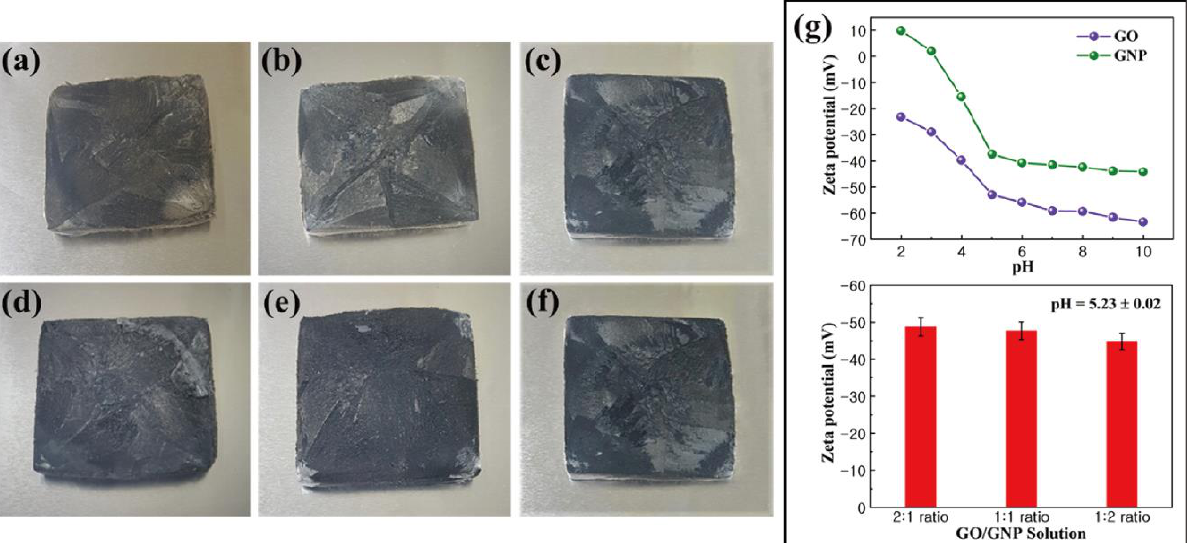
Figure 1. Schematics of the fabrication process for phase change material (PCM) composites by using the infiltration method. The thermoelectric energy harvesting system could generate induced current and turn on the LED bulb.